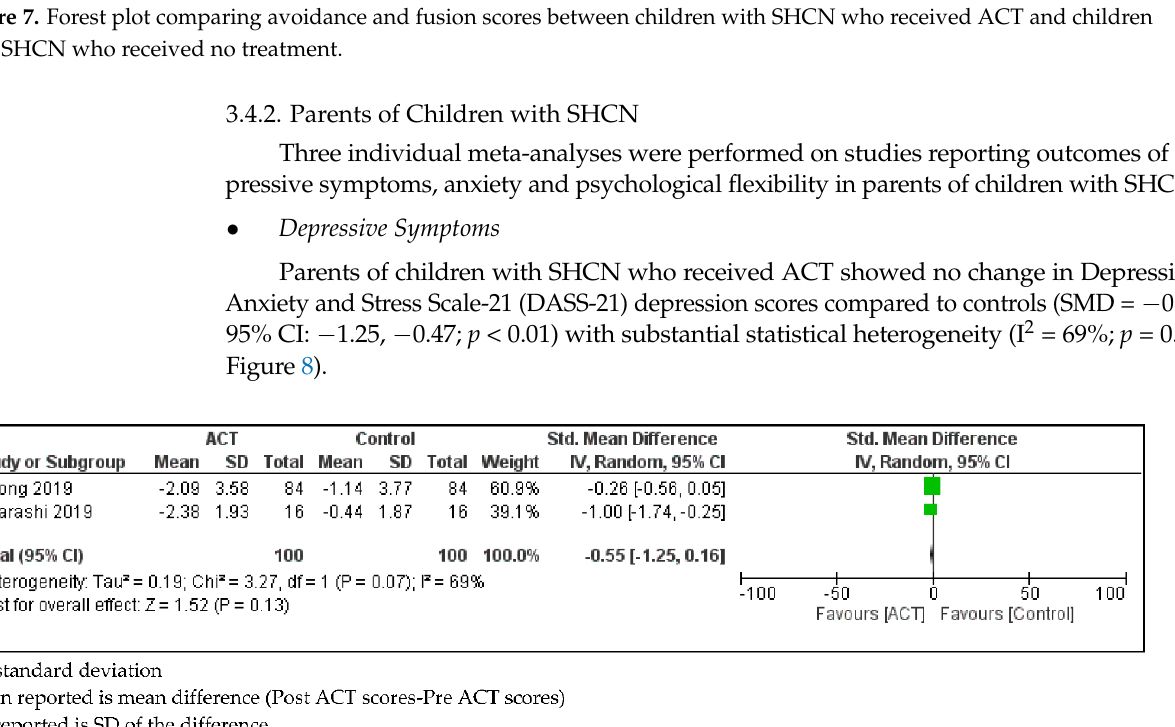
Figure 8. Forest plot comparing Depression, Anxiety and Stress Scale-21 (Depression) scores between parents of children with SHCN who received ACT and parents of children with SHCN who received no treatment.